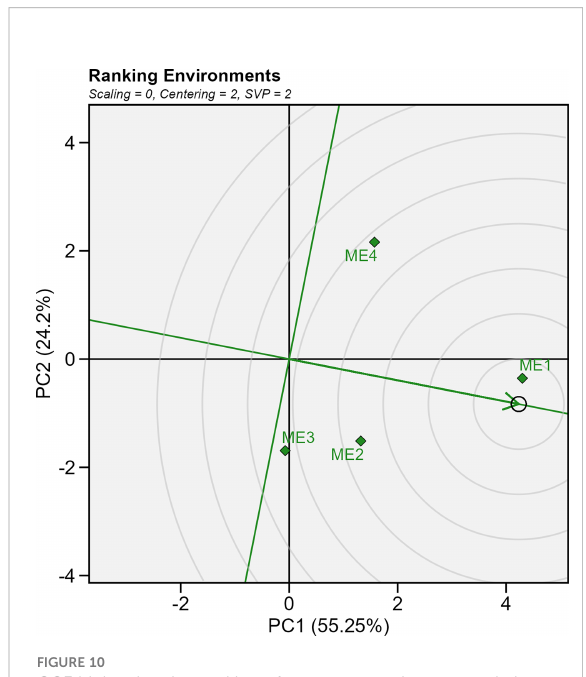
FIGURE 10 GGE biplot showing ranking of test mega-environment relative to an ideal test